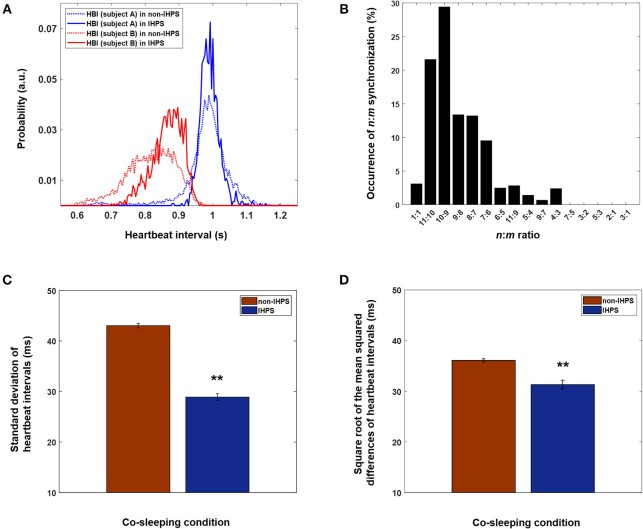
Different n:m ratios of IHPS at a Δ of 4 and characteristics of heart rhythms in IHPS and non-IHPS in co-sleepers. (A) Distributions of heartbeat intervals in IHPS and non-IHPS for a pair of co-sleepers. Narrow and center-concentrated distributions, which are also characterized by a decreased standard deviation of heartbeat intervals, are observed for both heartbeat intervals in IHPS (solid lines) when compared with those in non-IHPS (dashed lines). The distribution of one individual's heartbeat intervals in IHPS (solid red line) shifts in the direction of the co-sleeper's dominant heartbeat interval (solid blue line). In this pair of individuals, the most prevalent n:m ratio is 10:9. Therefore, one individual's heartbeat intervals are distributed in a particular range where the n:m ratios are satisfied (around 0.9 s). This indicates that the frequency of the intrinsic rhythm is adjusted because of the interaction, which corresponds to the fundamental characteristics of synchronization. The distributions of heartbeat intervals are determined with a time resolution of 4 ms, which matched the sampling rate (250 Hz) of the recording. The integration of the area in each distribution is 1. (B) Various ratios of IHPS close to 1:1 are observed in co-sleeping individuals. The IHPS does not always meet a 1:1 ratio, but different frequency ratios could exist near a 1:1 ratio when their phases are modulated to satisfy the synchronization condition. The histogram is determined with time duration of each n:m IHPS divided by the total time duration of IHPS observed in all pairs of co-sleeping individuals. (C) Standard deviation of heartbeat intervals in IHPS and non-IHPS for co-sleeping individuals. The error bars indicate the standard error. The values are 28.90 ± 0.68 ms and 43.04 ± 0.43 ms in IHPS and non-IHPS, respectively (**p < 0.001, independent-samples t-test). (D) Square root of the mean squared differences of heartbeat intervals in IHPS and non-IHPS for co-sleeping individuals. The error bars indicate the standard error. The values are 31.32 ± 0.87 ms and 36.09 ± 0.33 ms in IHPS and non-IHPS, respectively (**p < 0.001, independent-samples t-test).